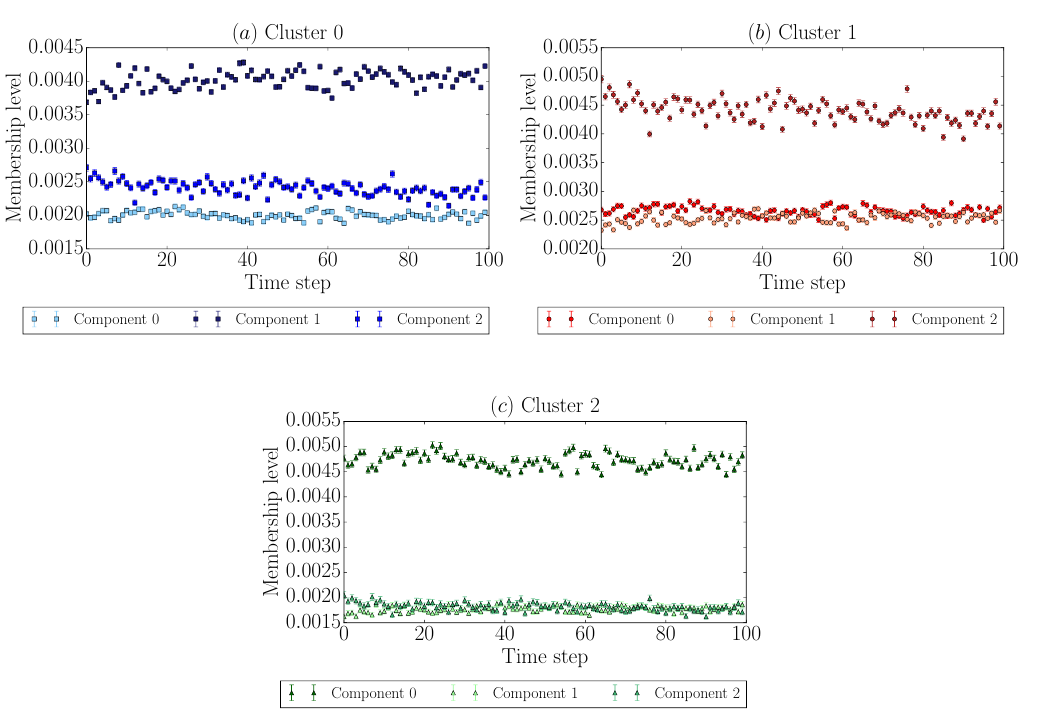
Figure 4. Membership modulated in time, given by the product a r c T r . The product is computed by separately taking into account the users belonging to the different clusters. For each cluster we report the mean of the users’ membership to each component over time, and the related standard error, marked with an error bar. Different shades of blue for cluster 0, red for cluster 1, and green for cluster 2 are assigned to distinguish the